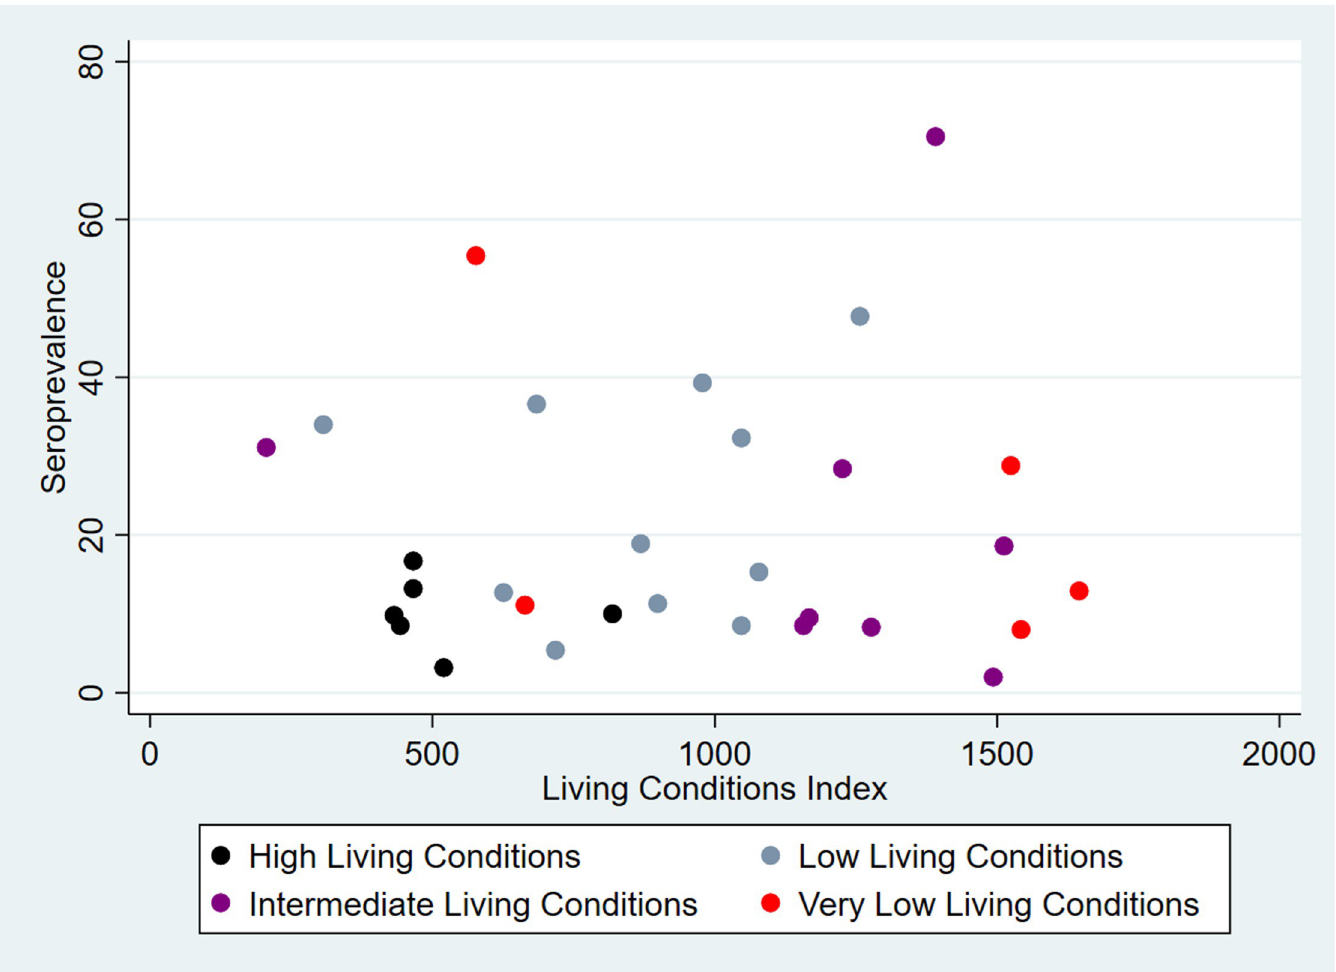
Fig 5. Scatterplots for the relationship between CHIKV seroprevalence and Living Conditions Index of Sentinel Areas by Living Condition Strata in Feira de Santana. Bahia-Brazil, 2017.